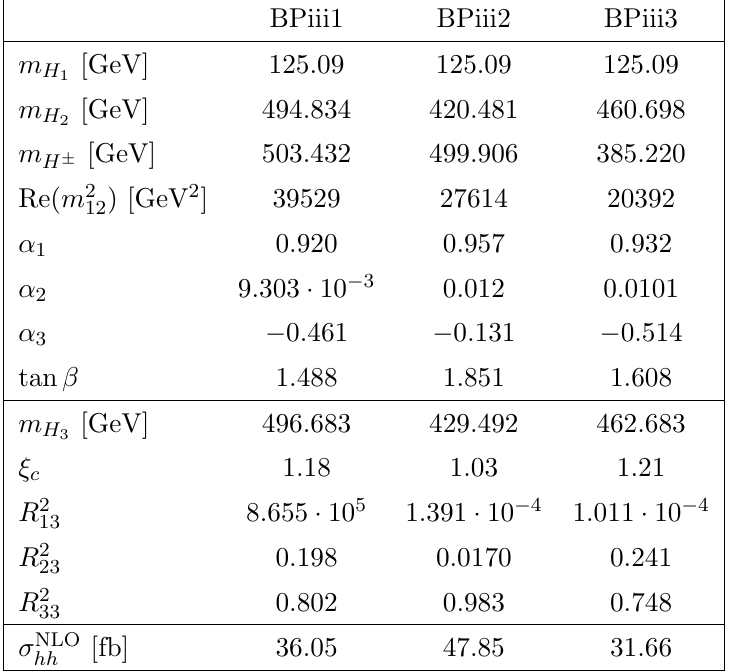
Table 6 . Line 1-8: the input parameters of the benchmark points BPiii1-3. Line 9 to 13: the derived 3rd neutral Higgs boson mass, the (cid:24) c value and the CP-odd admixtures R 2 NLO QCD gluon fusion hh production cross section at p s = 14 TeV.